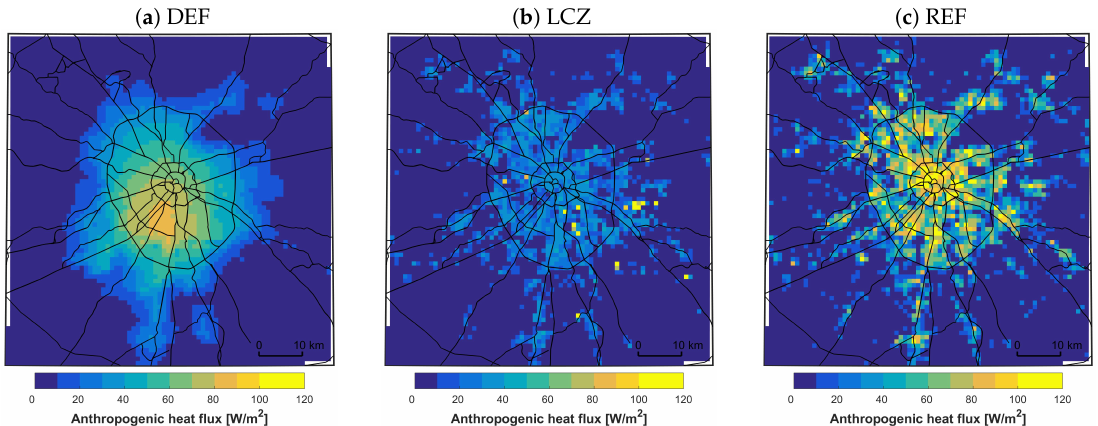
Figure 5. Comparison between mean annual anthropogenic heat flux according to DEF ( a ), LCZ ( b ) and REF ( c )